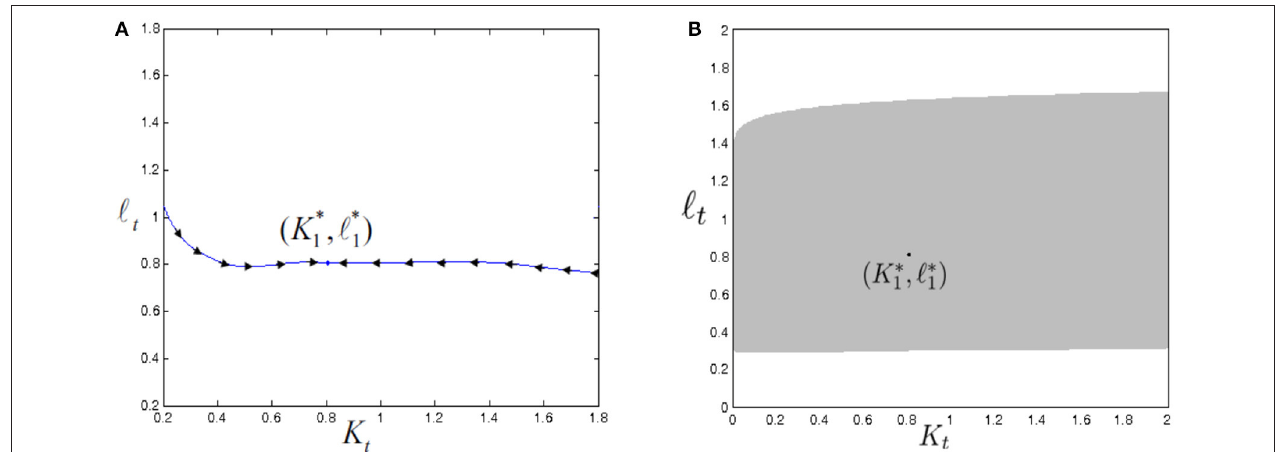
FIGURE 10 | Figure reproduced with the permission of the publisher. Source: Antoci et al. [18]. (A) Stable manifold of the locally determined fixed point ( K * 1 , l * 1 ), obtained for ρ = 0.2. (B) Basin of attraction (in gray) of the locally indeterminate fixed point ( K * 1 , l * 1 ) for ρ = 1.